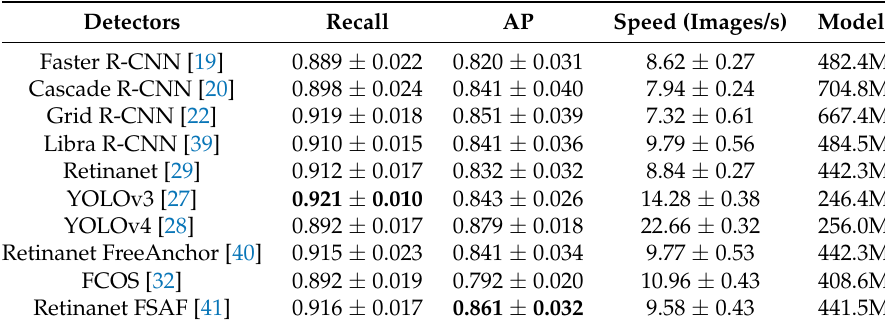
Table 7. Results on mixed resolution EPD-S subset. Train resolution, 1–2 m/pixel; test resolution, 1–2 m/pixel. AP refers to average precision. Recall, AP, and speed are expressed in the format of mean ± standard deviation on the basis of 10 rounds of test results.